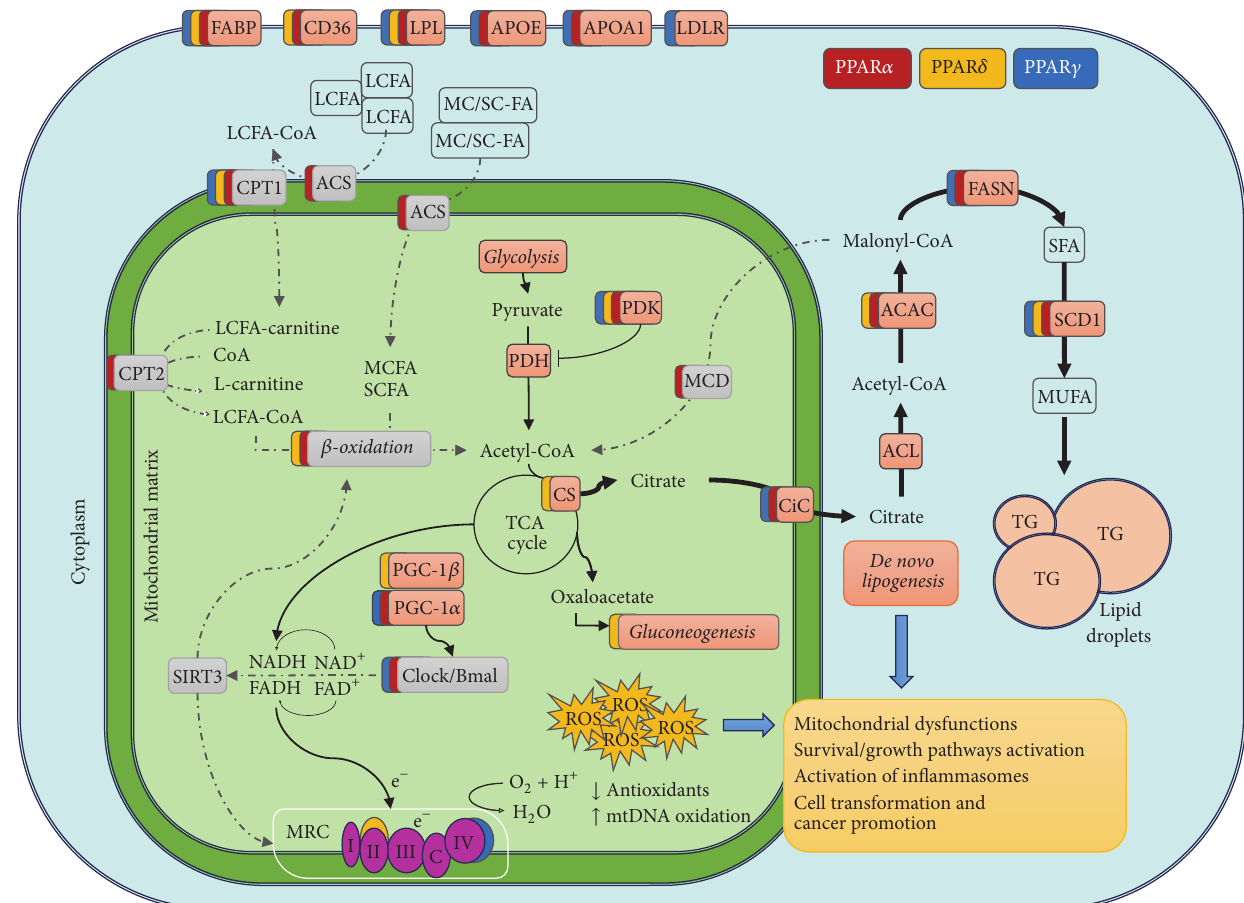
Figure 2: Altered mitochondrial metabolism in NASH and HCC: role of PPARs. Altered PPARs expression drives metabolic dysfunctions in the mitochondria leading to suppression of FAO, disruption of circadian rhythms, increased ROS levels, and upregulation of de novo lipogenesis. Color-coding depicts PPAR isotypes-dependency of target